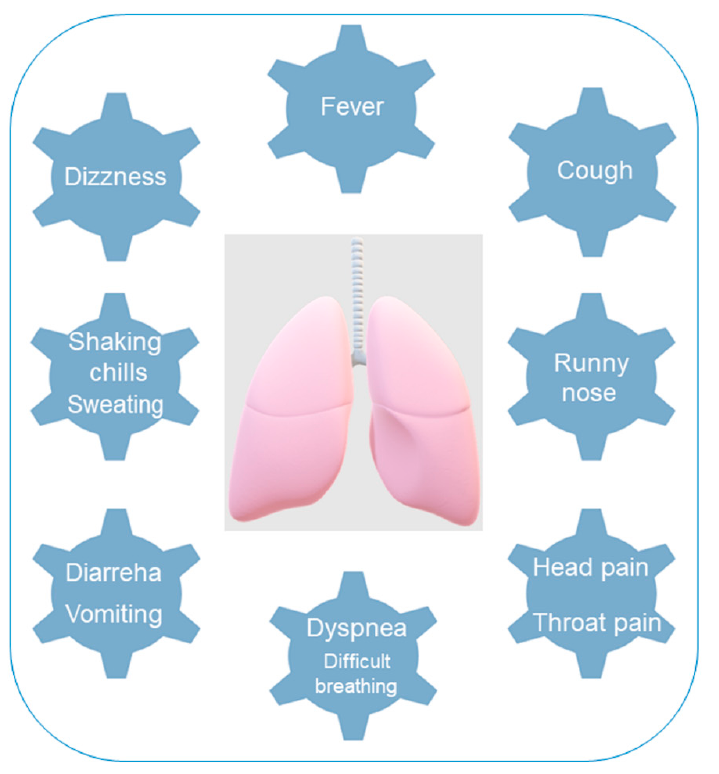
Figure 3. Symptoms of COVID-19. The figure graphically represents the most reported symptoms of COVID-19.